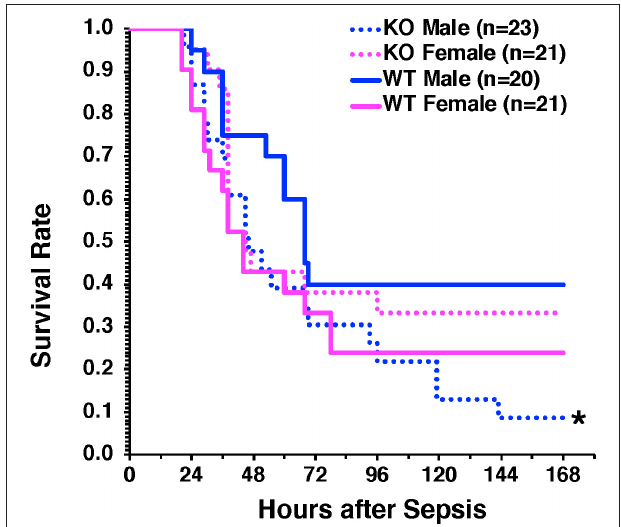
FIGURE 6 | Survival rate of hepatocyte-specific (H- AMPK α 1) wild-type (WT) and knock-out (KO) mice at 7 days after cecal ligation and puncture (CLP). Mice were subjected to CLP and received fluid resuscitation (35 ml/kg normal saline with 5% dextrose subcutaneously) immediately after, at 3h and every 24h after the CLP procedure up to 72h. * P < 0.05 of KO males vs. WT males as determined by Gehan-Breslow